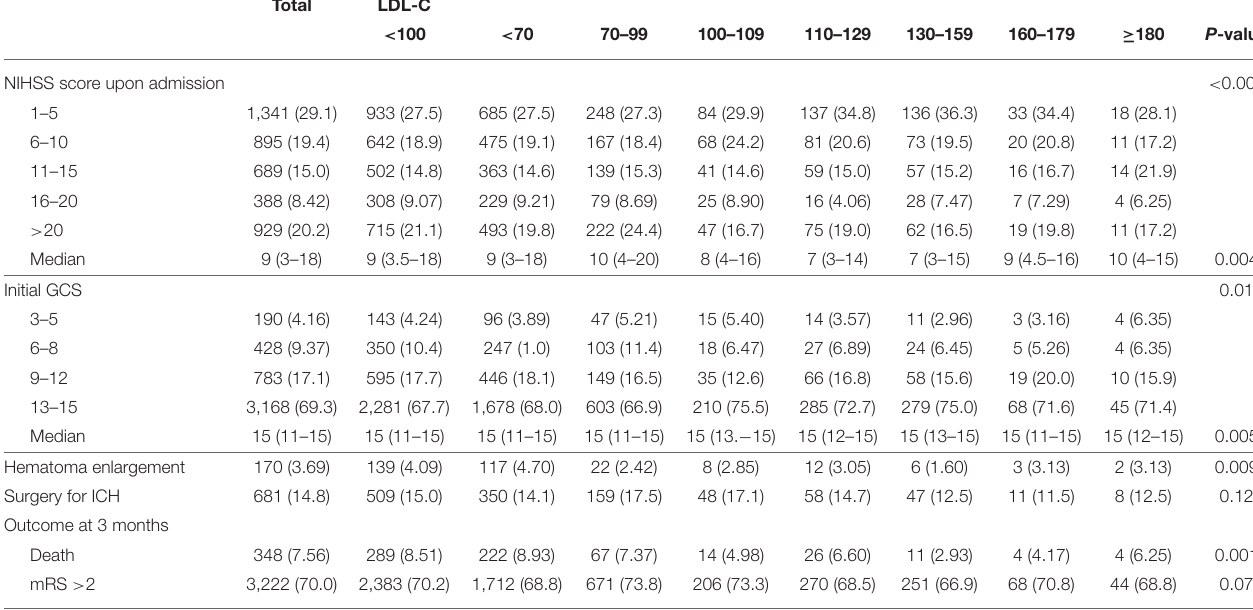
TABLE 4 | Condition of the study population in TSR, n